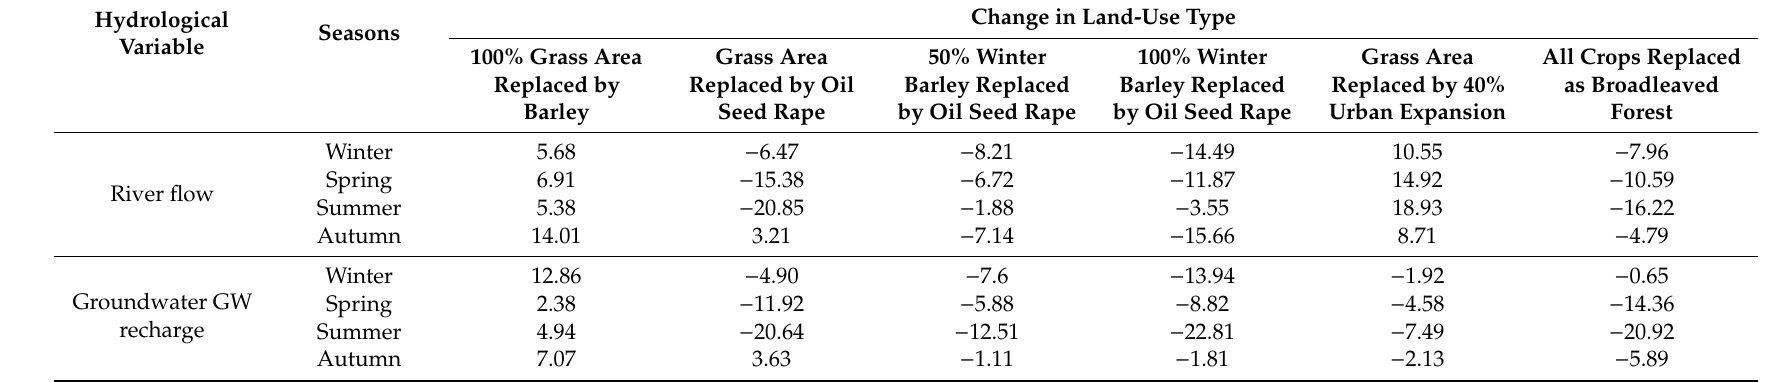
Table 3. Impact of land use changes in the Frome catchment on selected hydrological